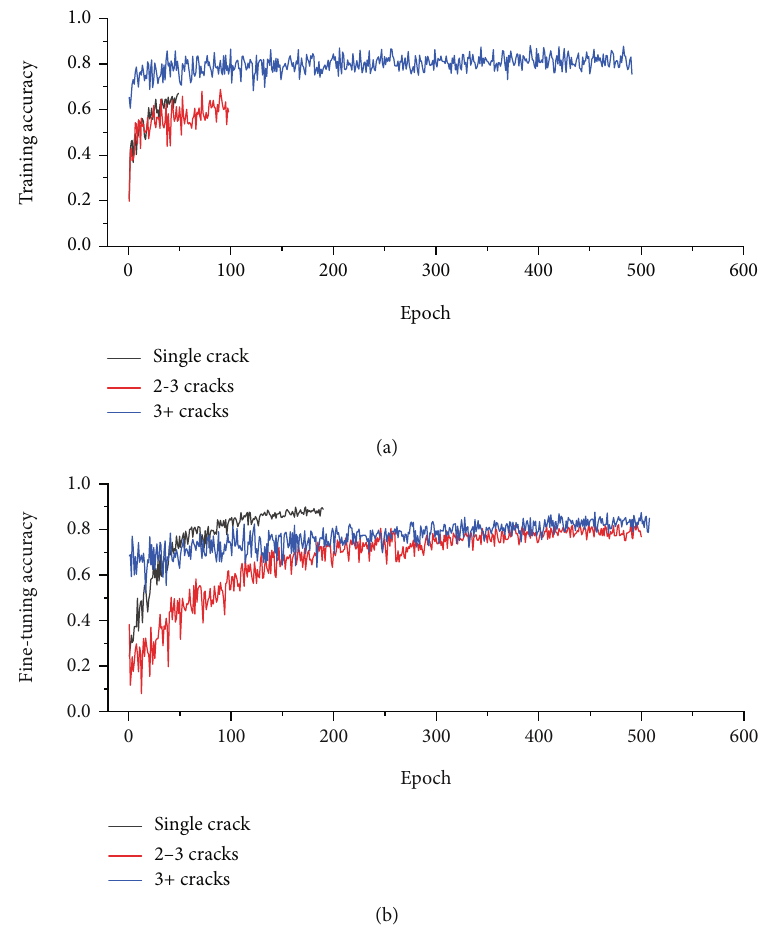
Figure 18: Training and fi ne-tuning process. (a) Training accuracy; (b) fi ne-tuning accuracy. (Single crack represents the model only trains on subdatabase S1-1 in the fi rst stage; 2-3 cracks represent the model trains on subdatabases S1-1 and S1-2 in the second stage; 3+ cracks represent the model trains on subdatabases S1-1, S1-2, and S1-3 in the third